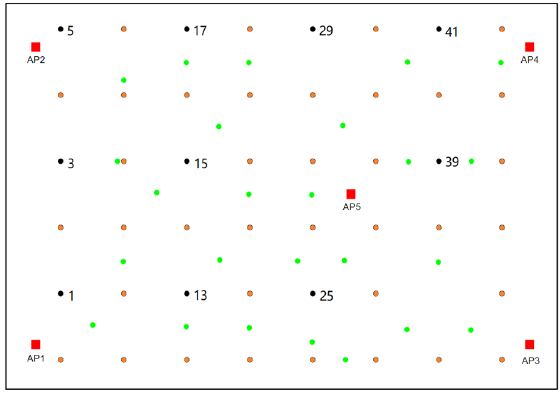
Figure 7. Distribution of the spatial interpolation fingerprints and the SS-RSS fingerprints. The red “ □ ” represents the fi ve APs; the black dots with labeled numbers denote the coarse grids; the pink dots represent the simulated fingerprints of the spatial interpolation or the SS-RSS construction; the green points represent the test-points.